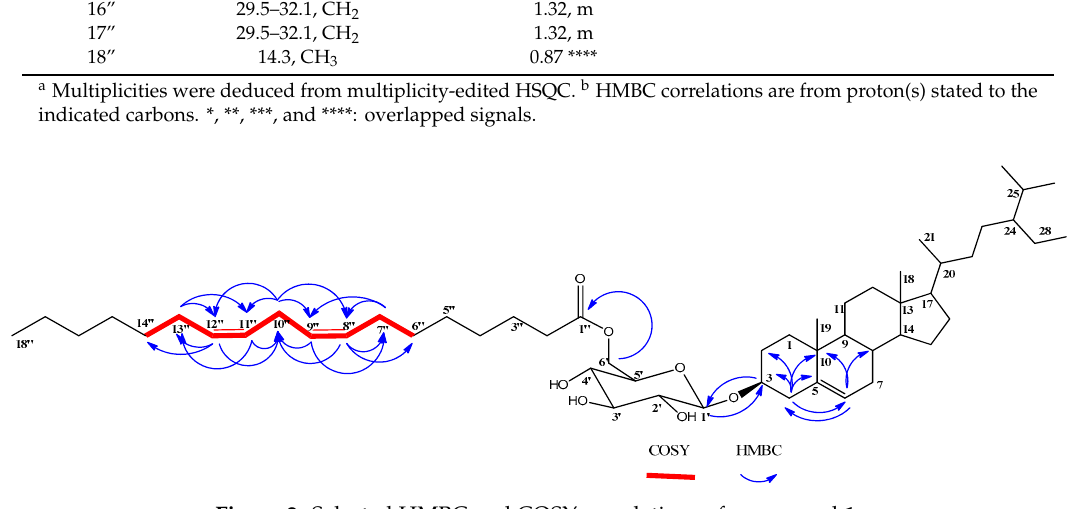
Figure 2. Selected HMBC and COSY correlations of compound 1.